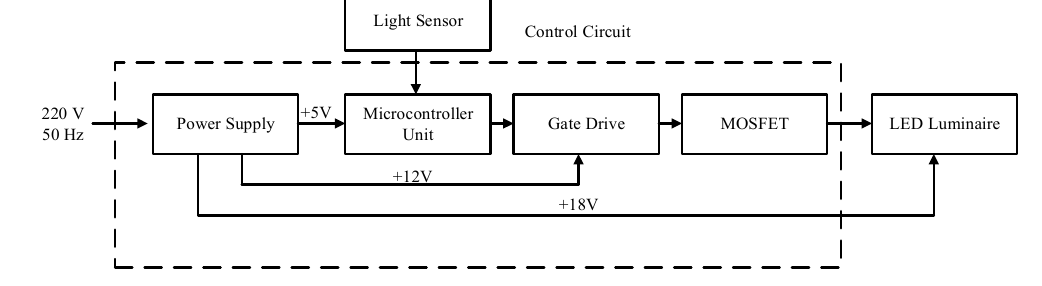
Figure 6. Diagram of the daylight control circuit for LED luminaire.